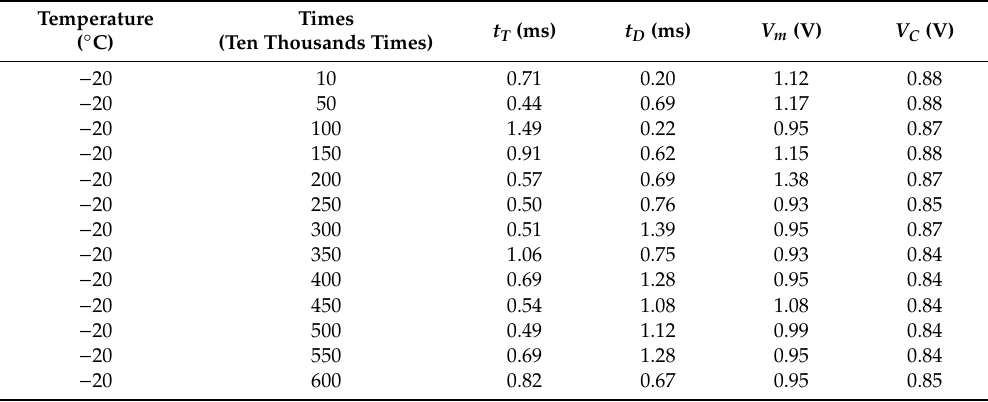
Table 2. Experimental results of relay at − 20 ◦